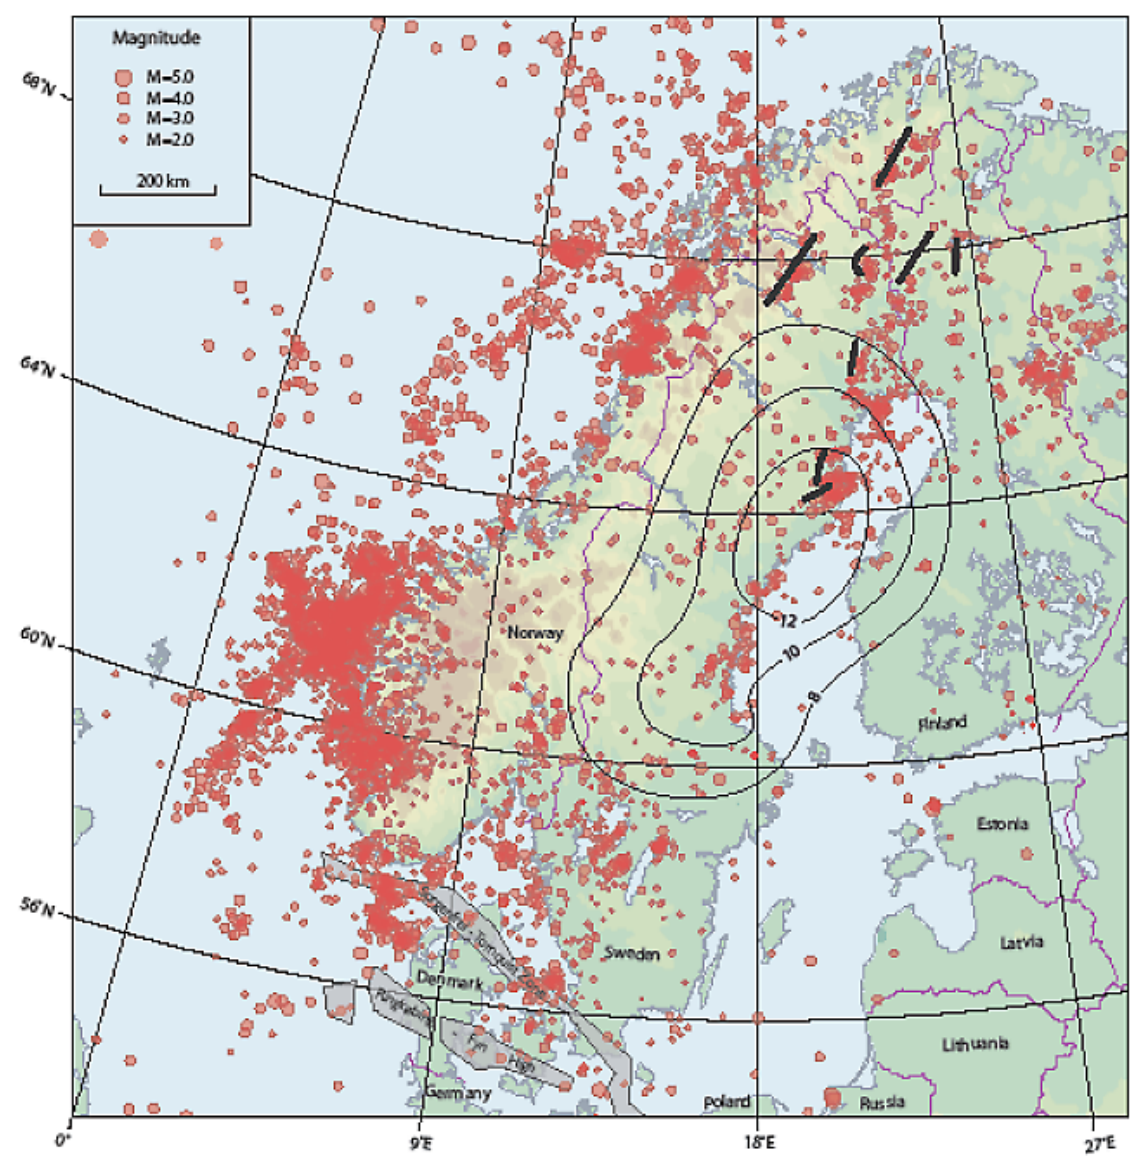
Fig. 1. Map of the earthquake geography in Scandinavia covering the years from January 1970 to December 2004. Earthquakes in the Danish area are extracted from the GEUS earthquake catalogue and earthquakes located outside this area are extracted from the Scandinavian catalogue from Helsinki University. The earthquake magnitude scale is given in the upper left corner. Contour lines show uplift in millimetres per year. Very thick black lines show the large postglacial faults of age close to 9000yr (Lagerbäck, 1991). Updated earthquake files for Denmark are available in home page http://www.geus.dk/ under seismology, and for the rest of Scandinavia in home page http://www. seismo.helsinki.fi/. From Gregersen and Voss